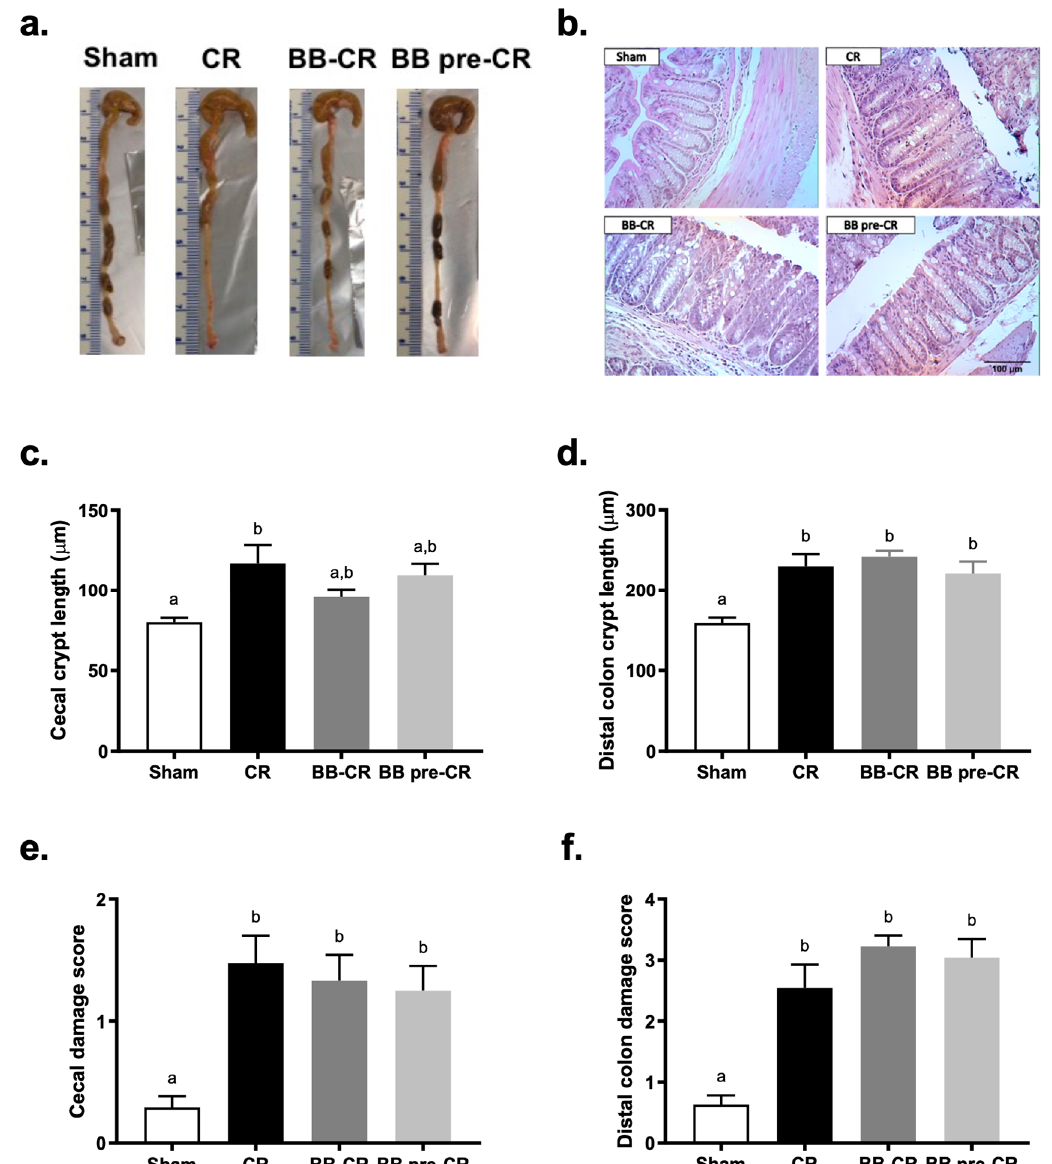
Figure 3. The effect of BB75 on intestinal crypt hyperplasia and tissue damage at day 10 p.i. ( a ) colon morphology; ( b ) representative H&E stained histology of distal colon tissues on day 10 p.i.; ( c ) ceacal morphology;